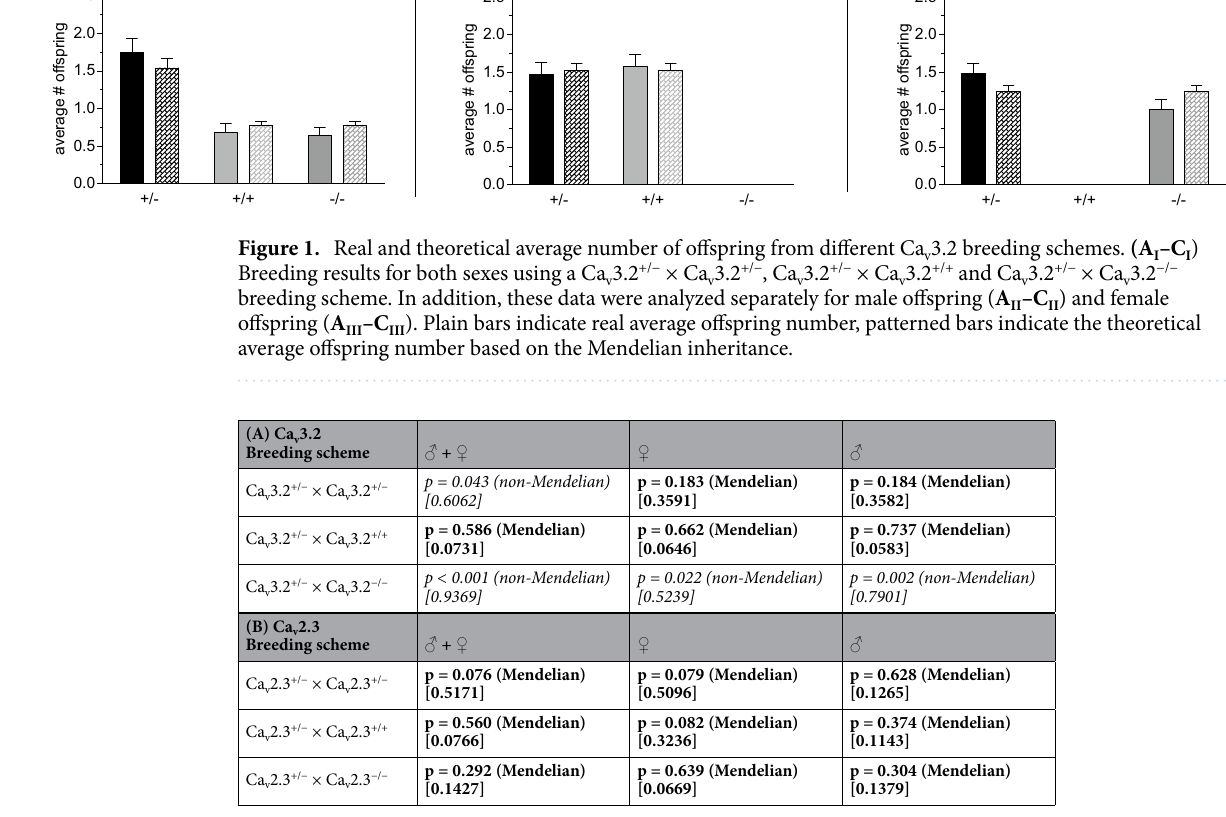
Table 1. Results of Chi-square testing for Ca v 3.2 and Ca v 2.3 breeding. Breeding results for Ca v 3.2 (see Suppl. Tab. 1–3) and